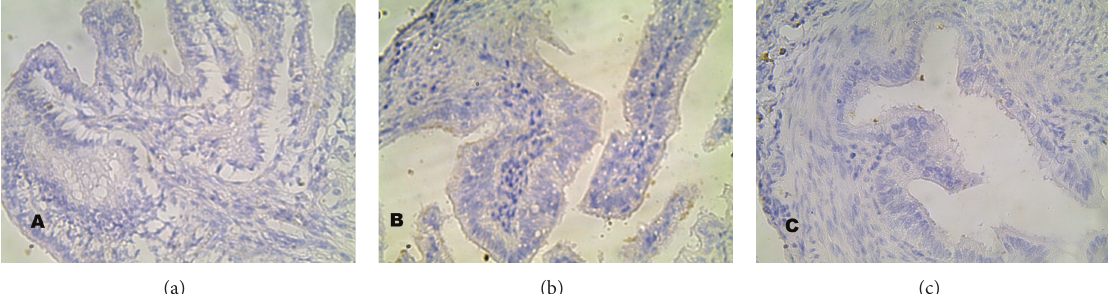
Figure 6: Expression of caspase 8 was at the low level in oviduct epithelial cells of control group (C), as well as study groups A and B (mag.